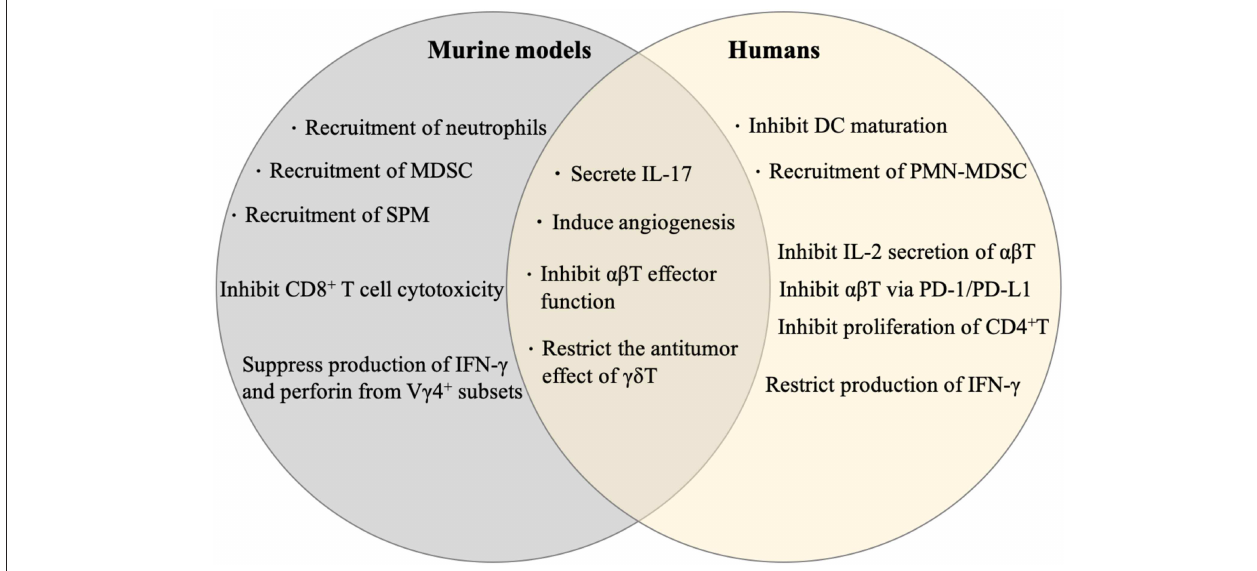
FIGURE 1 | Proposed mechanisms (differential and shared pro-tumor mechanisms) by γδ T17 in murine models and humans (2, 11–13, 16, 18, 19).